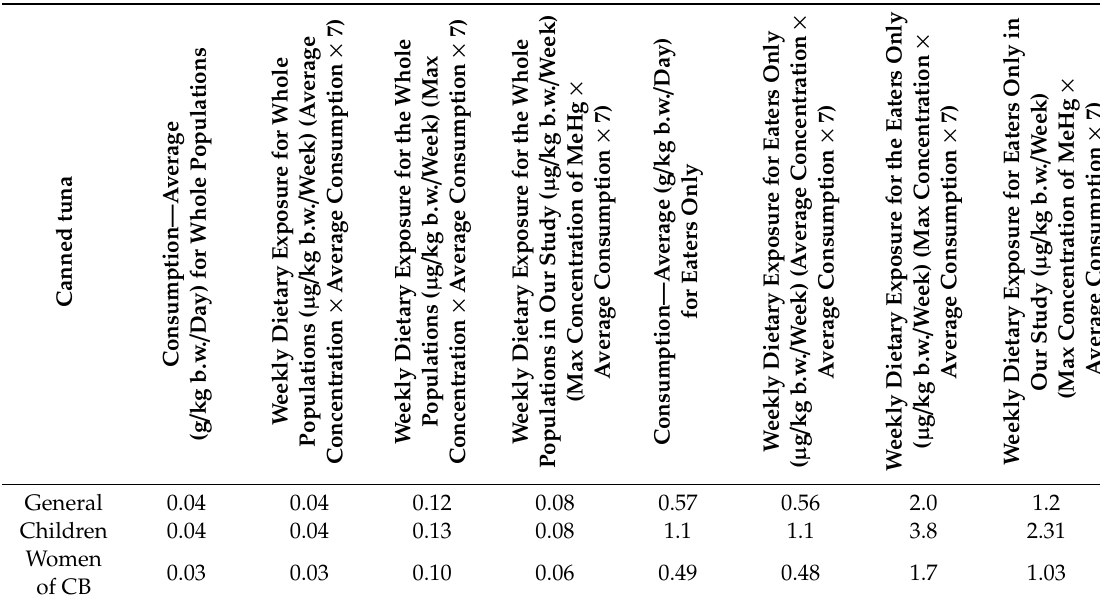
Table 6. The estimated weekly dietary exposures to methylmercury for the whole populations (eaters and non-eaters) and for eaters only ( µ g / kg b.w. / week) (PTWI: 1.6 µ g / kg b.w. / week). The data are calculated in relation to the canned tuna of Skipjack species. The mean content given in the